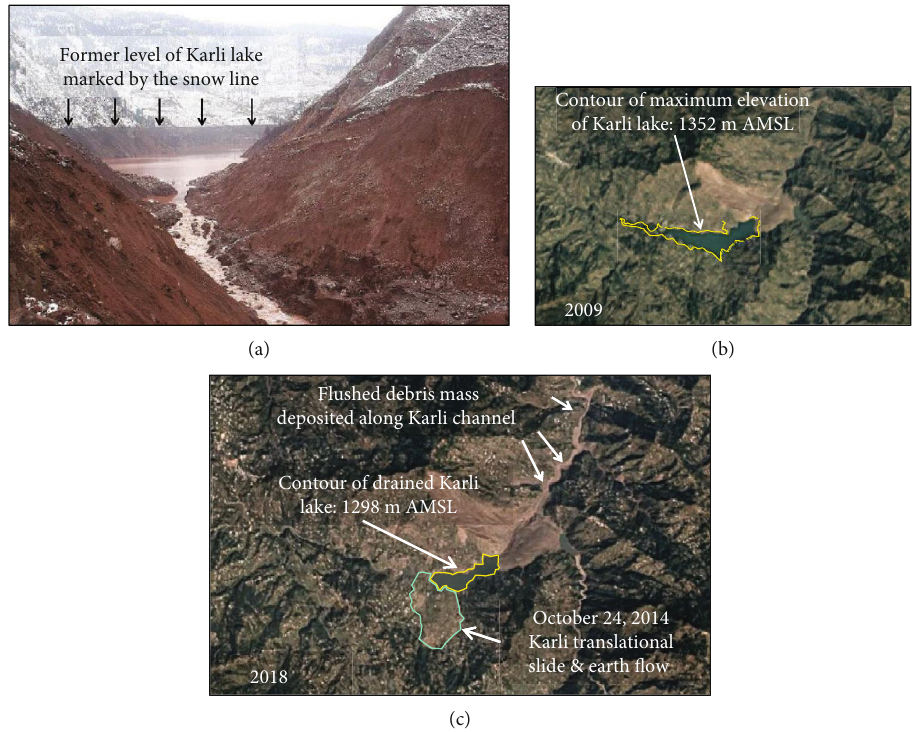
Figure 10: (a) Photograph showing the breached landslide dam in front of Karli lake (after [17]; photo courtesy of Dr. Kausar from GSP, dated February 10, 2010); (b, c) Google Earth Timelapse imageries of the Hattian Bala landslide area (year 2009, before landslide dam breaching, and year 2018, most recent available) [16,